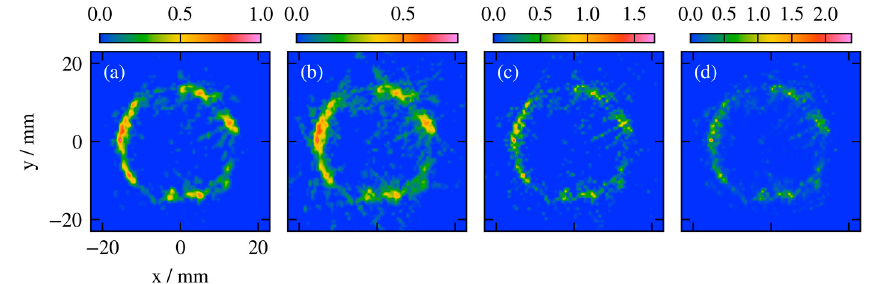
Figure 4. Reconstruction of a snapshot of the turbulent methane/air flame in Figure 2 (OH* @ 310 nm, exposure time 1 ms) using four different reconstruction algorithms: ( a ) 1 st -order Tikhonov regularization (this work), ( b ) 0 th -order Tikhonov regularization (Anikin et al. [3,4]), ( c ) ART and ( d ) MART. Intensities have been normalized to the maximum intensity in ( a ).